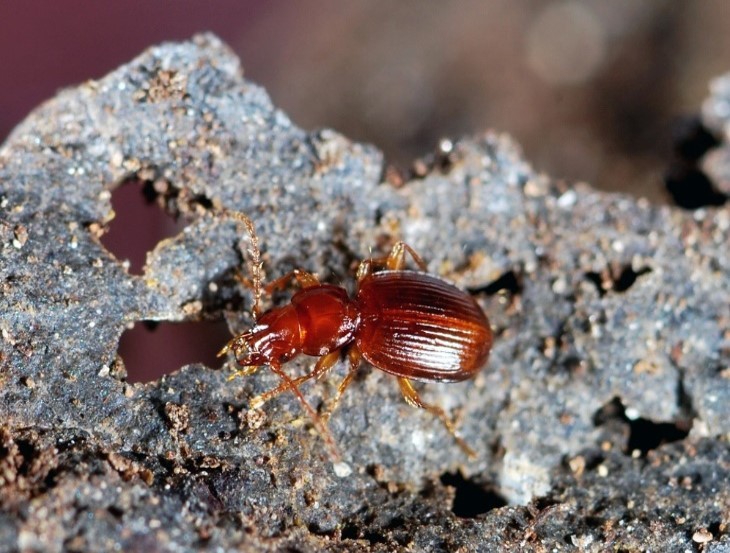
Trechus
terceiranus (Machado, 1988) from Terceira island (Azores, Portugal) (Credit: Paulo A.V. Borges).